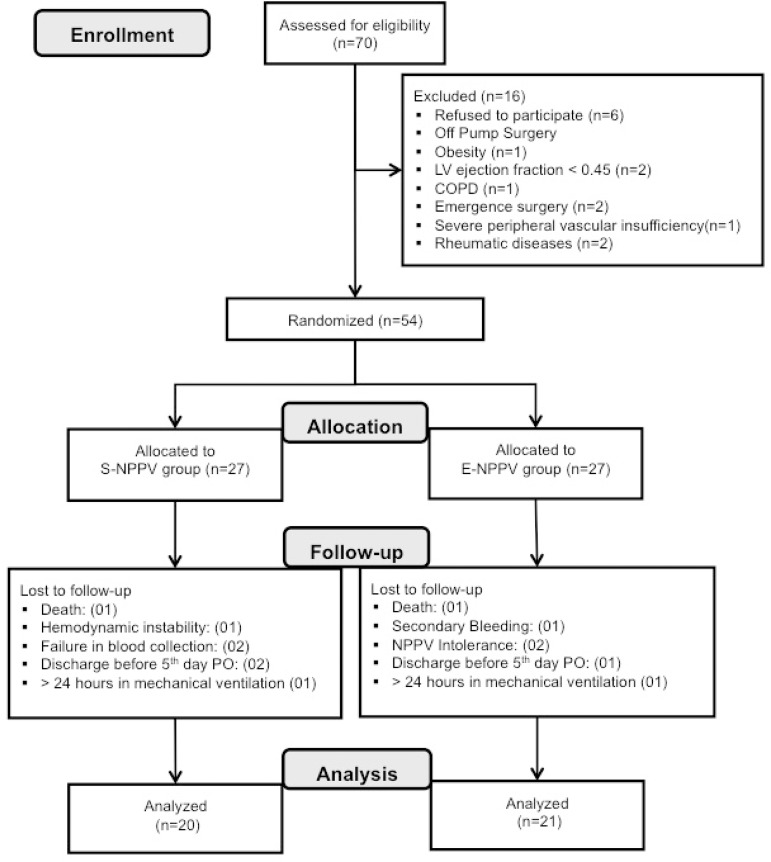
Flowchart of consecutive CABG patients enrolled in the study.CABG=coronary artery bypass surgery; COPD=chronic obstructive pulmonary
disease; E-NPPV=extended-time noninvasive positive pressure ventilation;
LV=left ventricular; PO=postoperative; S-NPPV=short-time noninvasive
positive pressure ventilation